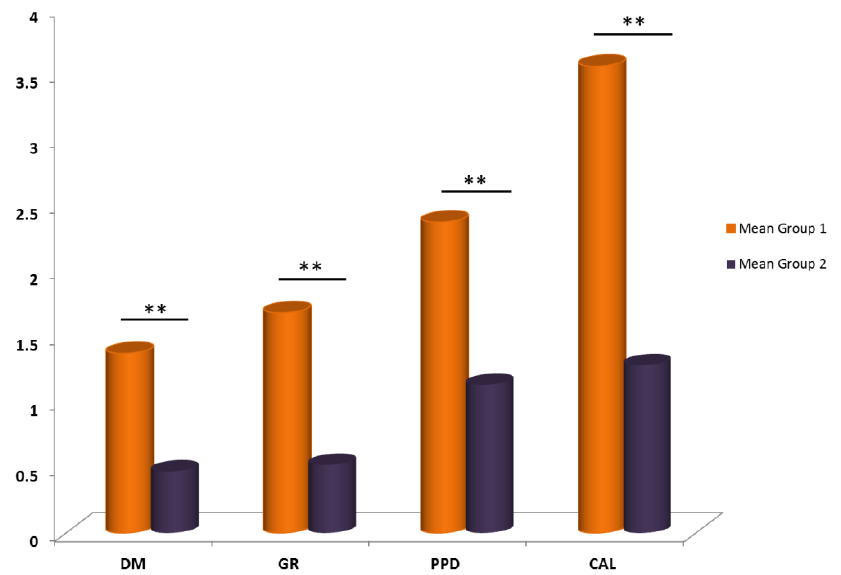
Figure 1. Comparison between periodontal parameters in group 1 vs. group 2 (DM—dental mobility,